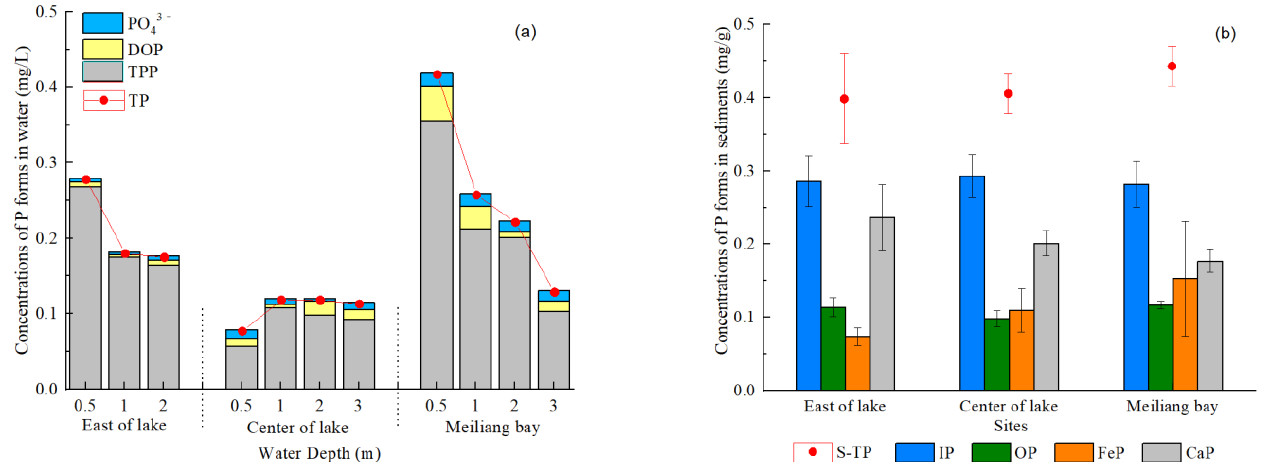
Figure 3. ( a , b ) Concentrations of P forms in water and sediments of Taihu Lake.